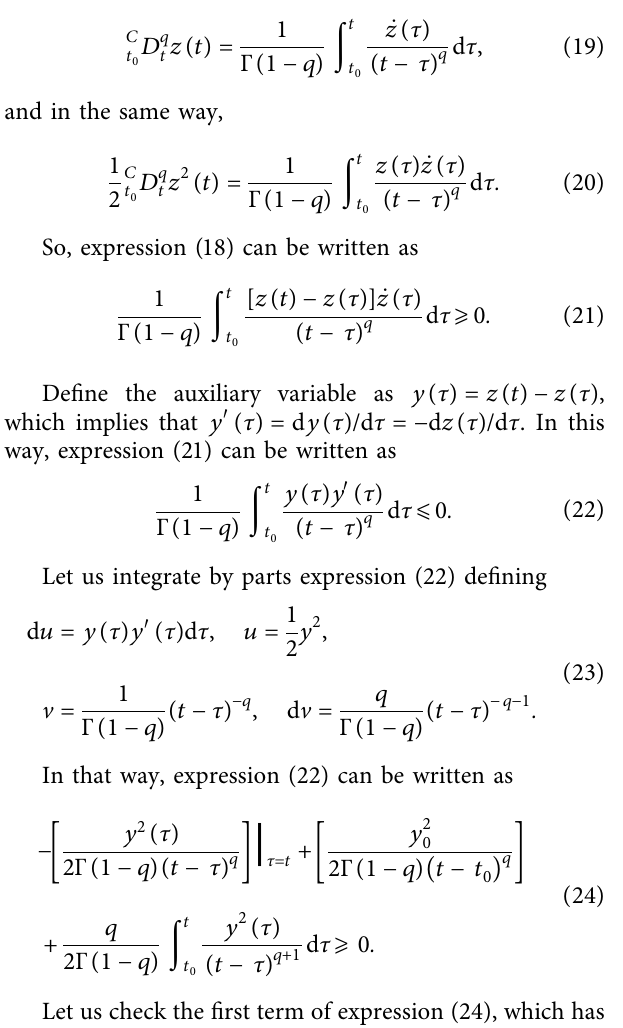
Figure 10: Phase portrait for fractional-order power system (10) at � 1 . 101, showing coexisting attractors for two different initial P m